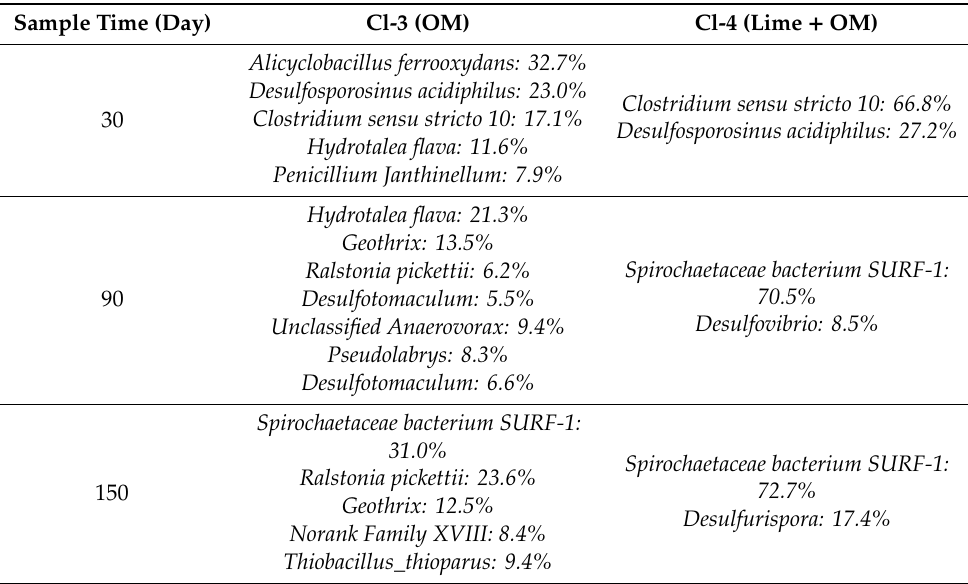
Table 4. Dominant species in the solution phase of organic addition columns (OM, Lime + OM) during the incubation in the column (abundance >